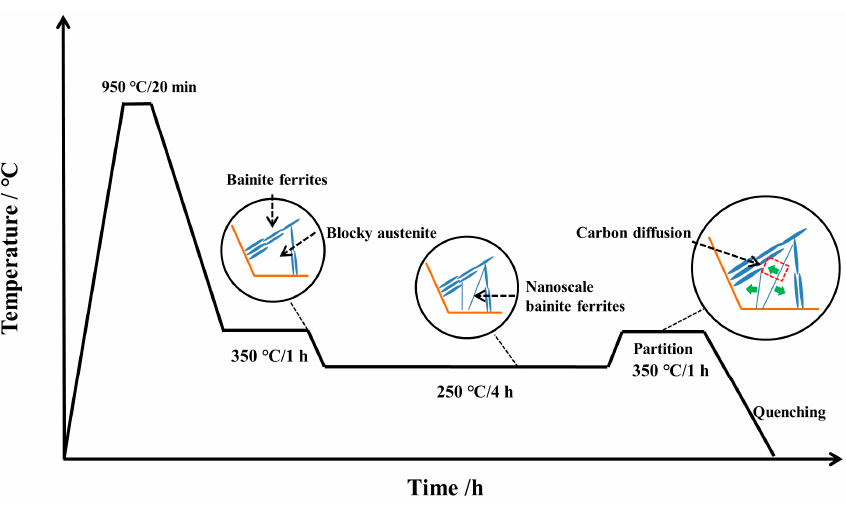
Figure 9. Schematic graph of the evolution of microstructures.